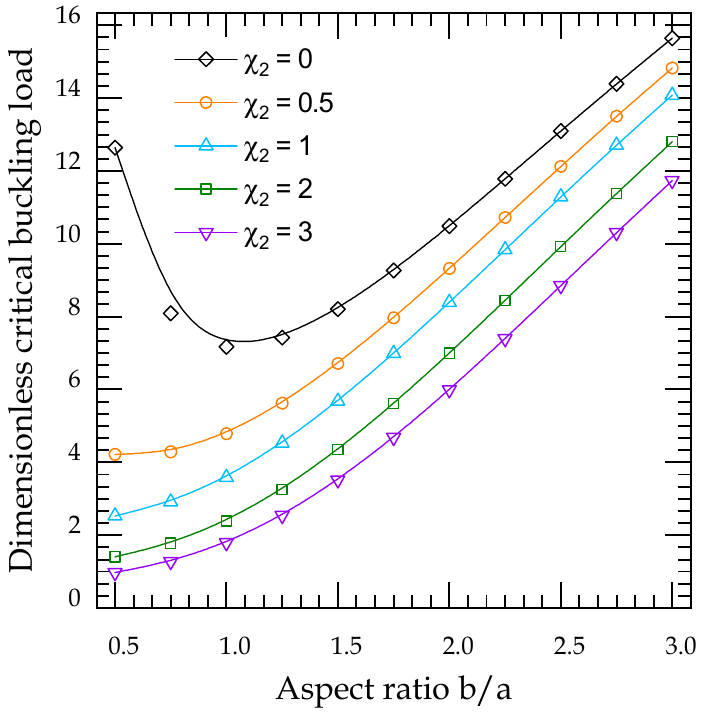
(cid:0) = 1%, a = 10 2 (cid:1) . g ∗ GPL / h GPL GPL ⁄ = 10 (cid:2870) ) . ℎ (cid:2891)(cid:2900)(cid:2896) (cid:2891)(cid:2900)(cid:2896)